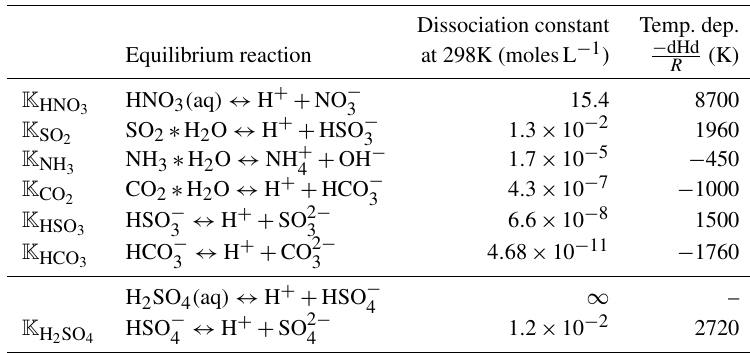
Table C2. Dissociation constants and their temperature dependence coefficients (taken from Kreidenweis et al., 2003). Dissociation of H 2 SO 4 is taken from Table 7A.1 in Seinfeld and Pandis (2016).